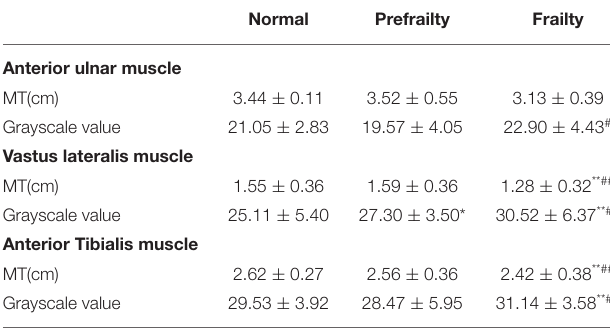
TABLE 2 | Local muscle thickness and muscle quality in control group, Prefrailty group and Frailty